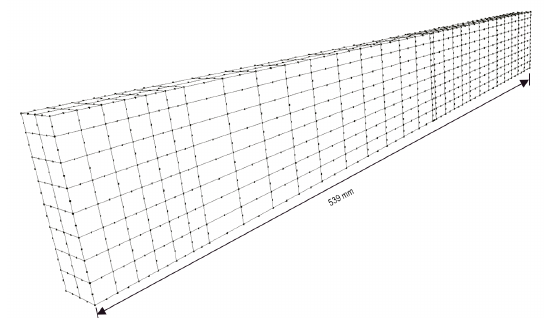
Figure 12. Perspective view of the BE model. Table 2. Boundary conditions for the bar.